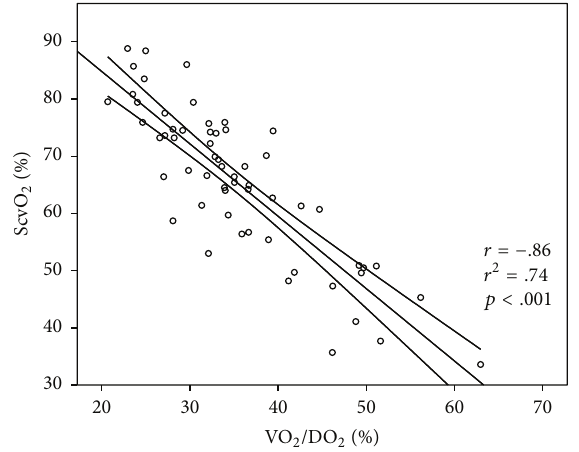
Figure 1: Correlation between VO 2 /DO 2 and ScvO 2 . Data are presented as scatter with a linear regression line and its mean 95% confidence interval. VO 2 /DO 2 : oxygen extraction, ScvO 2 : central venous oxygen